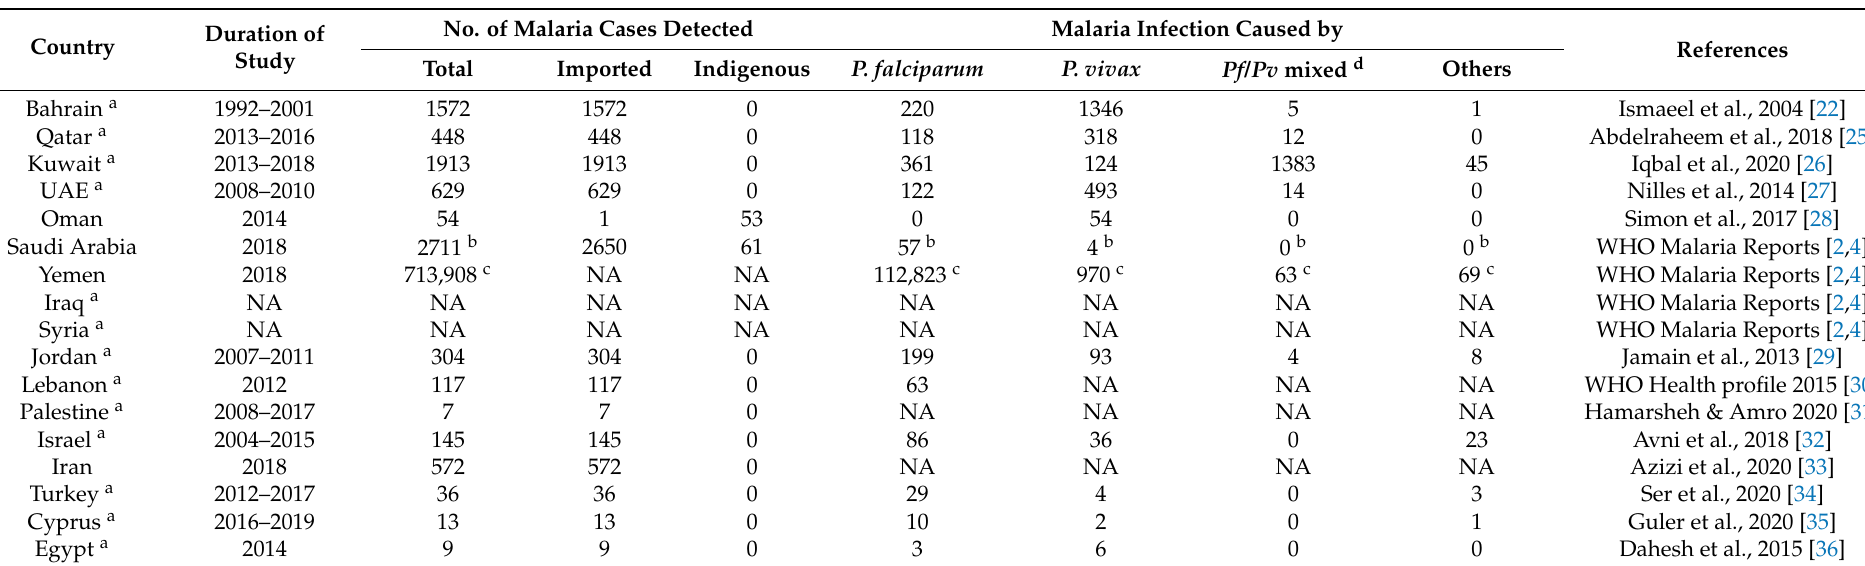
Table 1. Imported and indigenous malaria cases and species distribution reported in selected studies from the Middle East Region countries.